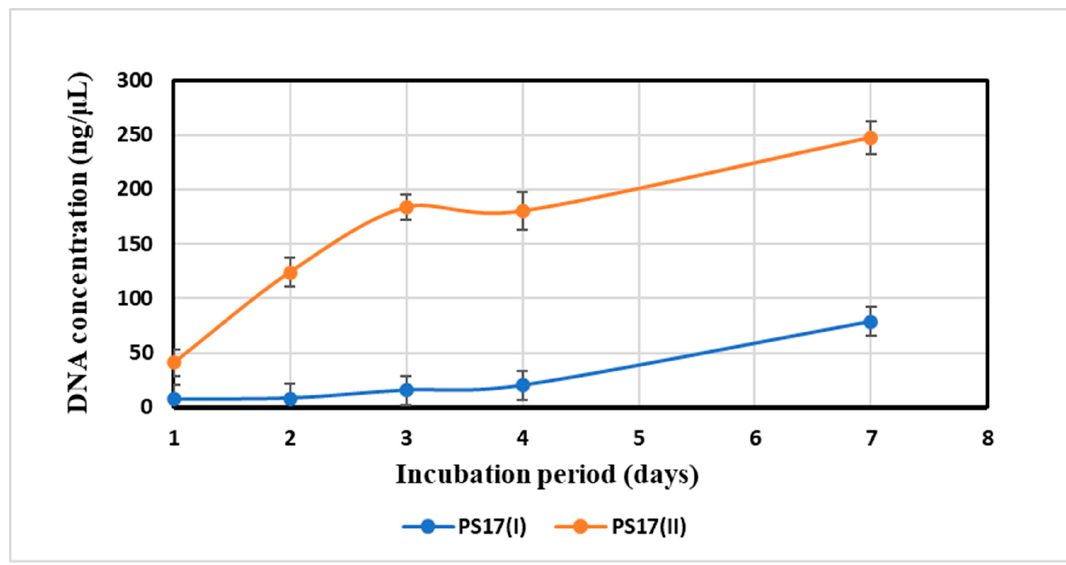
Figure 5. Cell lysis rate of B. mojavensis PS17 morphotypes.